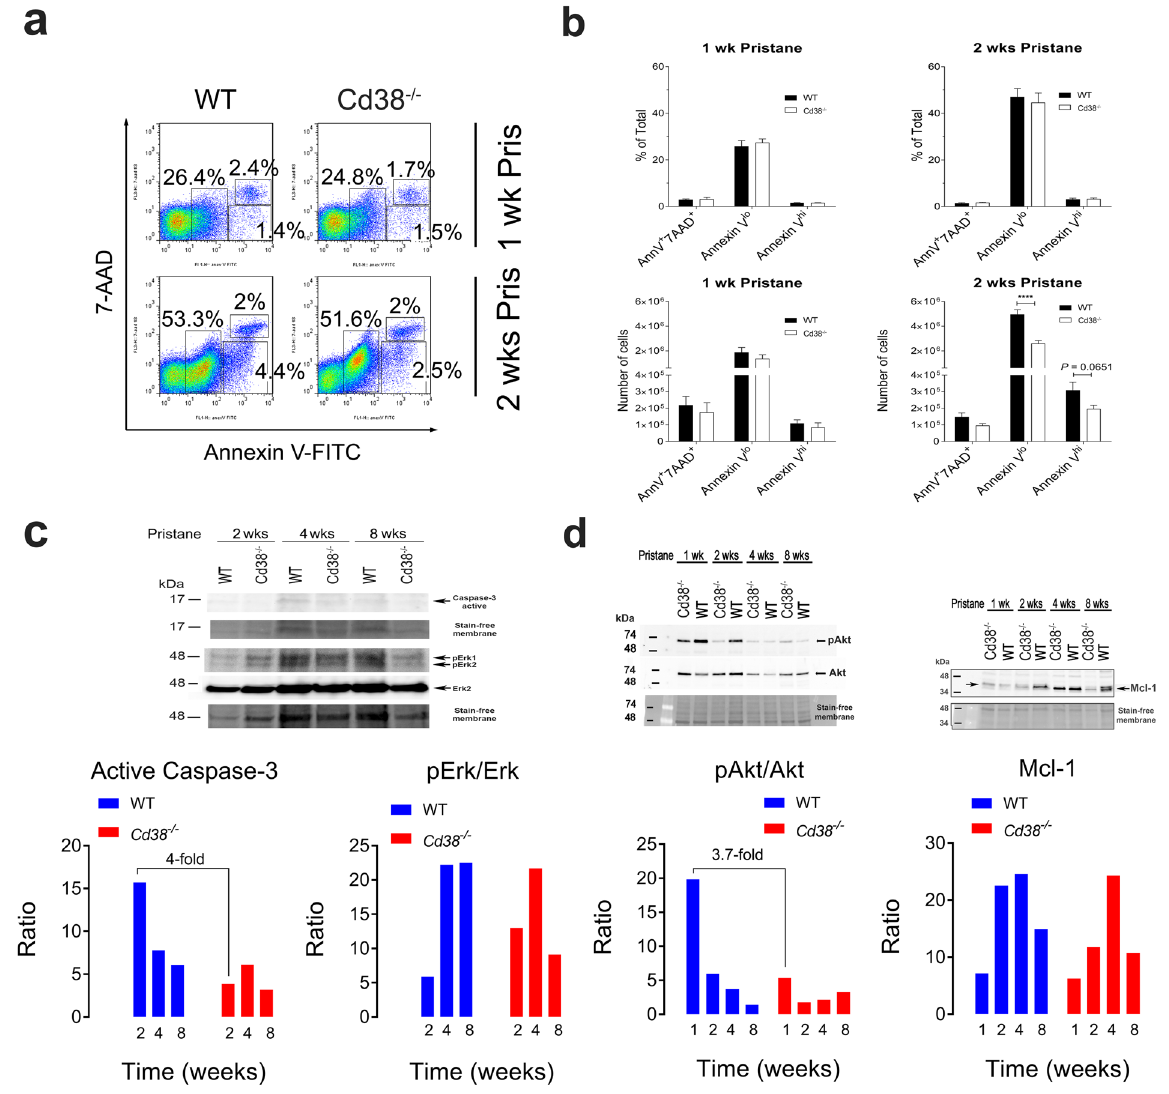
Figure 2. Defective caspase-3 activation in pristane-elicited PECs from Cd38 − / − mice. ( a ) Flow cytometric analysis of Annexin V (AnnV) and 7-AAD staining on PECs from 1-week pristane treated (upper panels) and 2-weeks pristane-treated (lower panels) WT and Cd38 − / − mice. Frequencies of early apoptotic (AnnV lo 7- AAD − ), late apoptotic (AnnV hi 7-AAD − ) and necrotic cells (AnnV hi 7-AAD + ) are shown. (b ) Frequencies (top panels) and absolute numbers (bottom panels) of necrotic, early apoptotic, and late apoptotic PECs from 1- and 2-weeks pristane-treated WT and Cd38 − / − mice. Closed (WT) and open ( Cd38 − / − ) bars represent the mean and the error bars indicate SE (n = 5-6 mice/group. P values were determined by 2-way ANOVA with the Bonferroni’s multiple comparisons test. **** P < 0.0001. (c ) Lysates from 2-, 4- and 8-weeks pristane-elicited PECs were subjected to Western blotting using antibodies specific for active caspase-3, phospho-Erk1/2 (Thr 185 / Tyr 187 ), total Erk1/2, and the corresponding stain-free areas of the PVDF membrane before blotting. Each lane represents a pool of 3 lysates from 3 mice/group. Densitometric analyses of the amount of active caspase-3 or phosphorylated Erk1/2 were done using the Image Lab software (Bio-Rad Laboratories). In the lower left and right panels the normalized amount of active caspase-3 and the pErk/Erk ratios are shown, respectively. (d ) Lysates from 1-, 2-, 4- and 8-weeks pristane-elicited PECs were subjected to Western blotting using antibodies specific for phosphorylated Akt and total Akt (upper left panel) or antibodies specific for Mcl-1 (upper right panel). In the lower left and right panels the pAkt/Akt ratios and normalized amounts of Mcl-1 are shown, respectively. In all blots, Stain-Free technology was used as the loading control method 88 . Images of the entire non-cropped membranes have been included as supplementary data in Figs